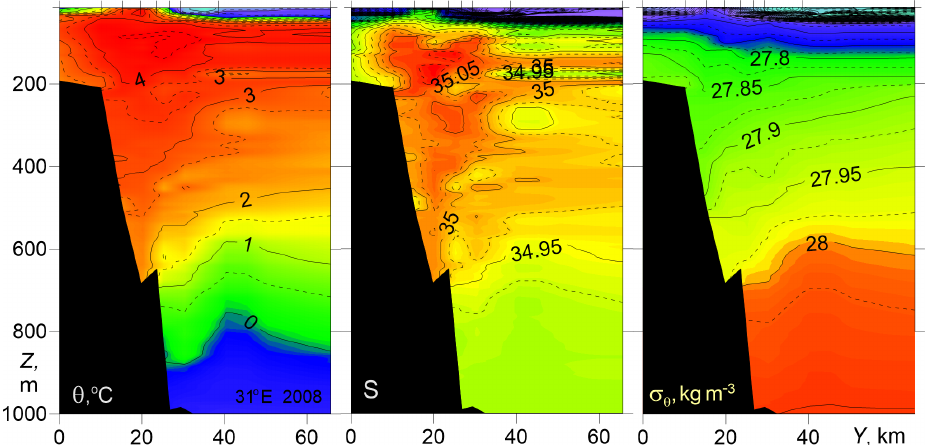
Figure 2. Temperature θ , salinity S , and potential density anomaly σ θ vs. cross-slope distance and depth for the NABOS08 transect across the Eurasian Basin slope at 31 ◦ E. Locations of the CTD stations are shown in the transects at the top. Here and hereinafter the NABOS expedition references are abbreviated: for example NABOS08 corresponds